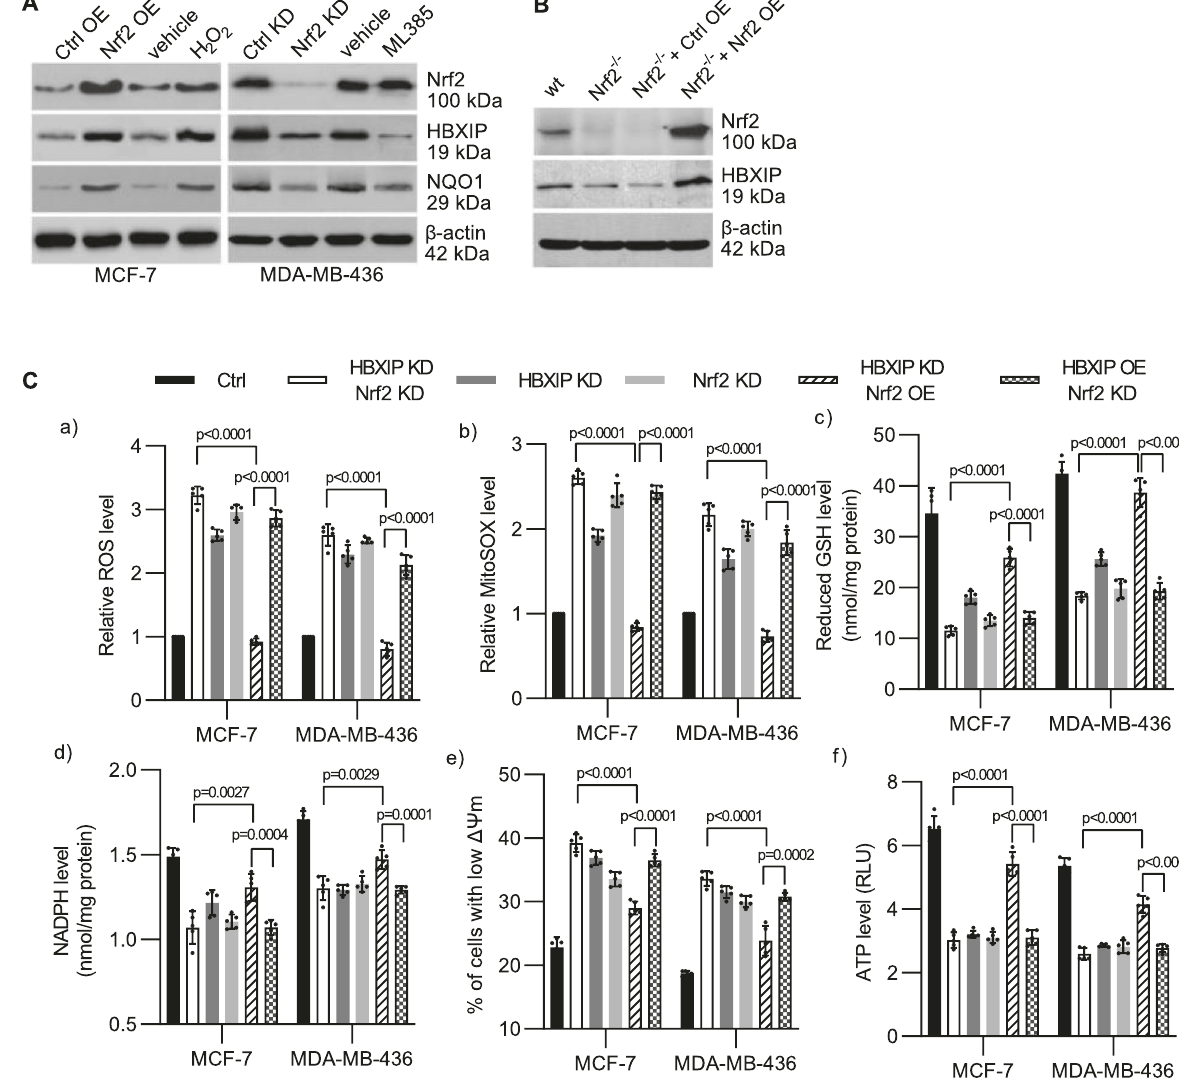
Fig. 4 The HBXIP/Nrf2 feedback loop regulates redox homeostasis in breast cancer cells following detachment. A MCF-7 cells were infected with pLVSIN-Nrf2 lentivirus or treated with 50 μ M H 2 O 2 . MDA-MB-436 cells were infected with pLKO-shHBXIP lentivirus or treated with 5 μ M ML385. The indicated treated cells were fractionated, and the expression of HBXIP and NQO1 was measured. B Wild-type MEFs and Nrf2 − / − MEFs infected with pLVSIN-Nrf2 lentivirus were fractionated, and the levels of Nrf2 and HBXIP were analyzed via western blotting. C Stable MCF-7 and MDA-MB-436 cells as indicated were cultured in suspension for 48 h and (a) stained with CM-H 2 DCFDA and subjected to fl ow cytometry to determine the intracellular ROS level; (b) stained with MitoSOX Red, and the ROS levels were determined; (c) used to measure the reduced GSH levels; (d) used to measure NADPH levels; (e) used for assessment of mitochondrial membrane potential using a JC1 assay; and (f) used for ATP measurement using an ATP determination kit. The error bars indicate the ±SD values as assessed by Student ’ s t test. All the experiments were performed at least three